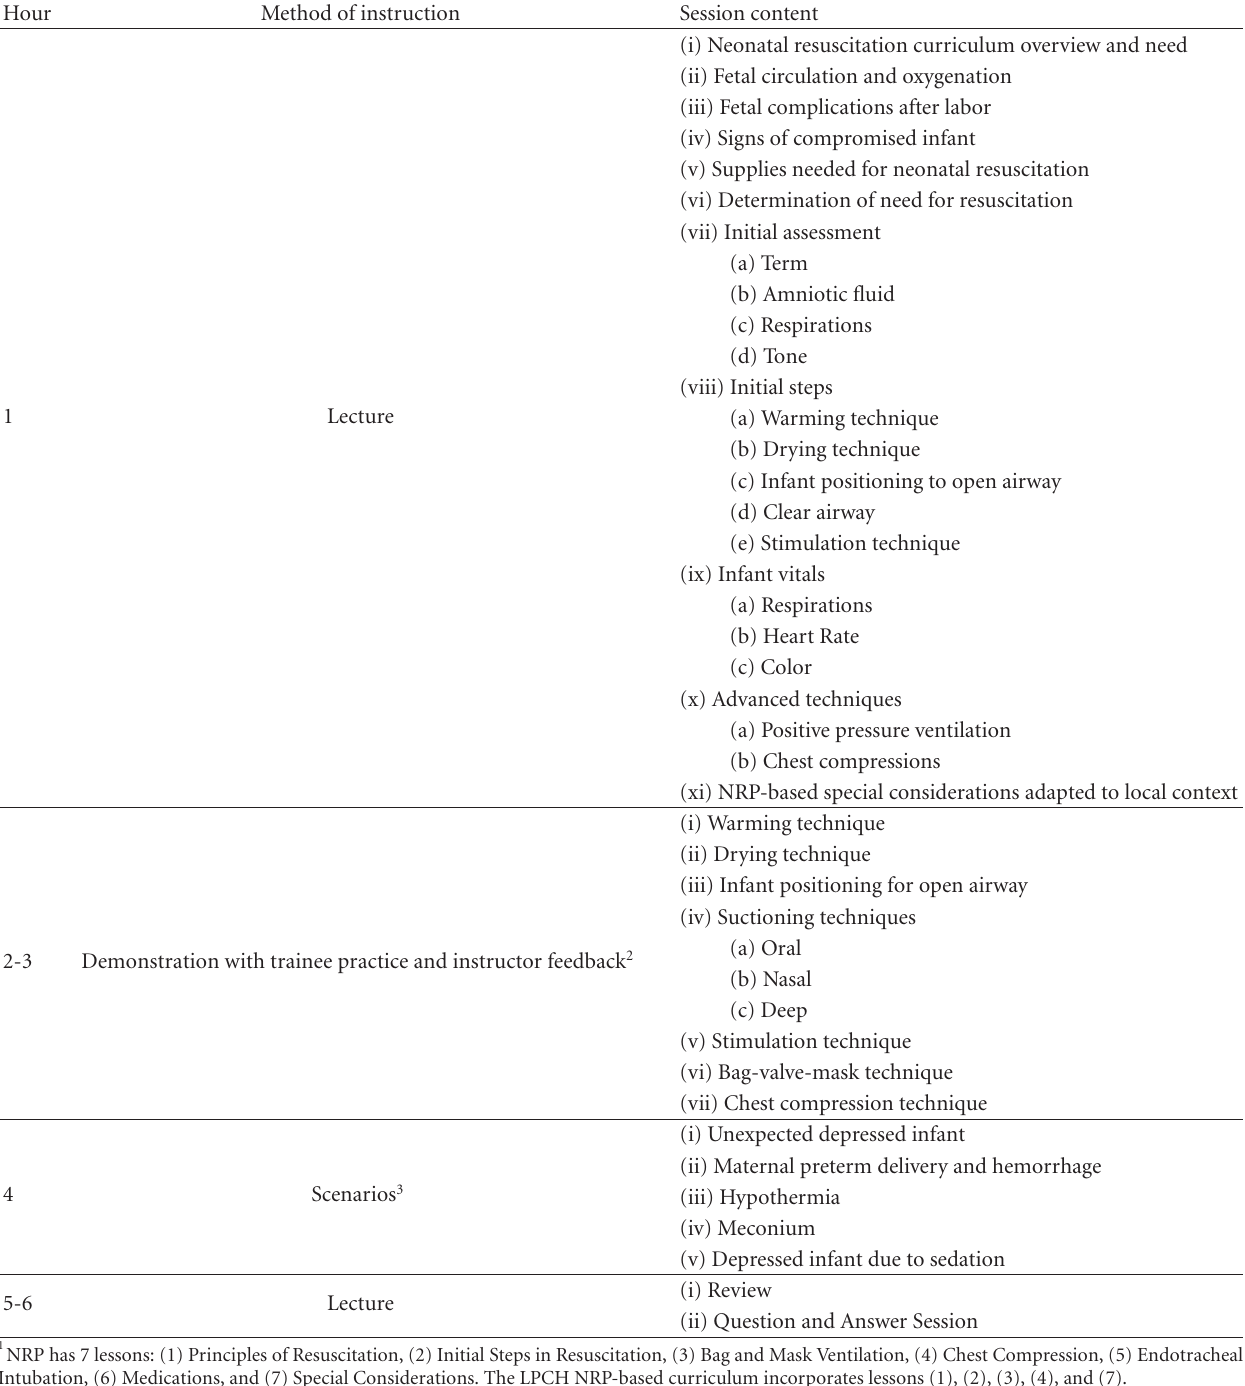
Table 1: LPCH neonatal resuscitation program curriculum 1